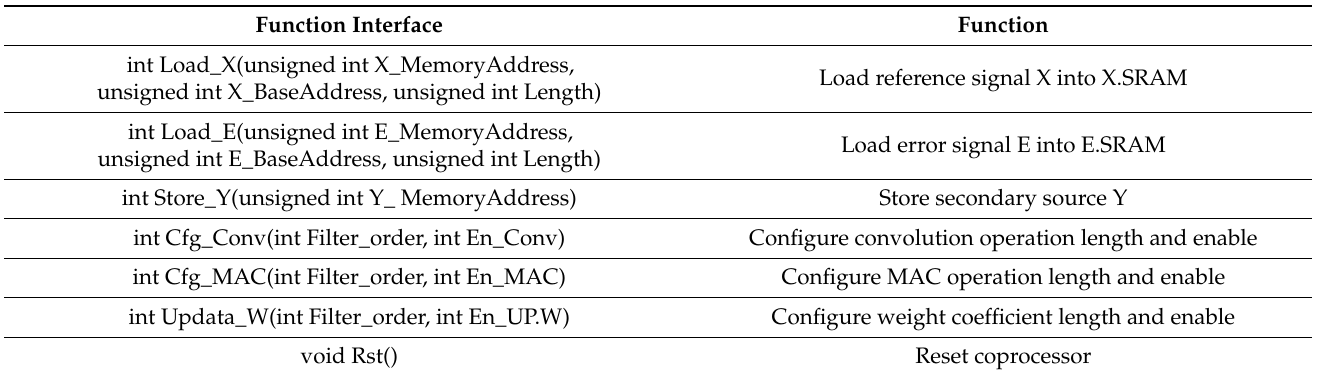
Table 2. Library functions of custom instructions and their introduction.